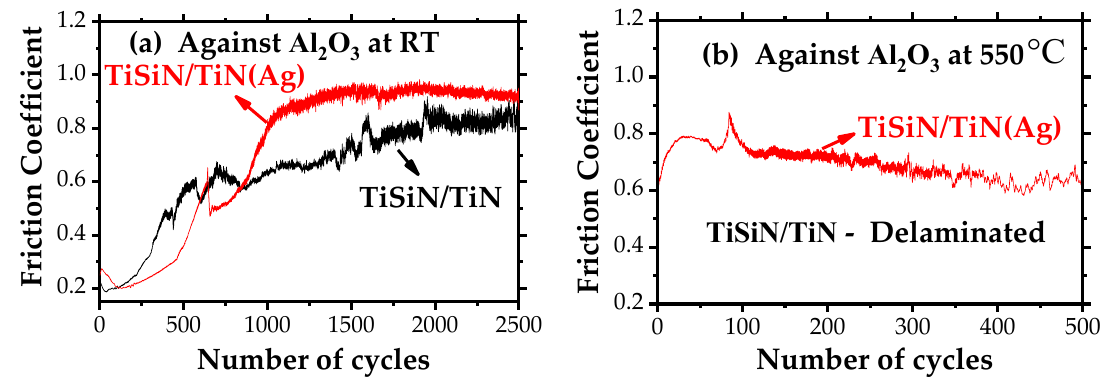
Figure 1. Friction coefficient of the TiSiN/TiN multilayer coatings with and without Ag addition as a function of the number of cycles tested against Al 2 O 3 balls at: ( a ) RT and ( b ) 550 °C.